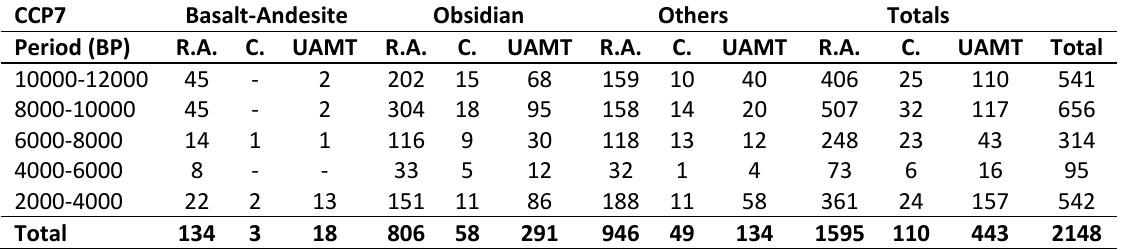
Table 1. Cerro Casa de Piedra 7 (CCP7) lithic assemblages by period. RA: Retouched artefact; C: core; UAMT: Unretouched artefact with marginal